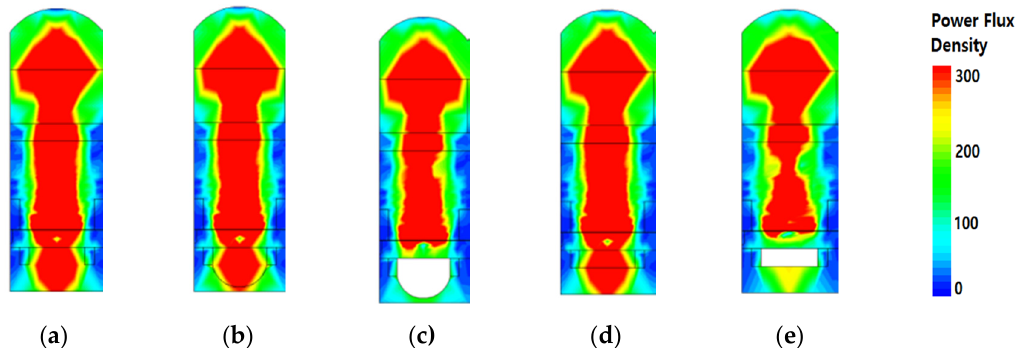
front-inner lens with air. of